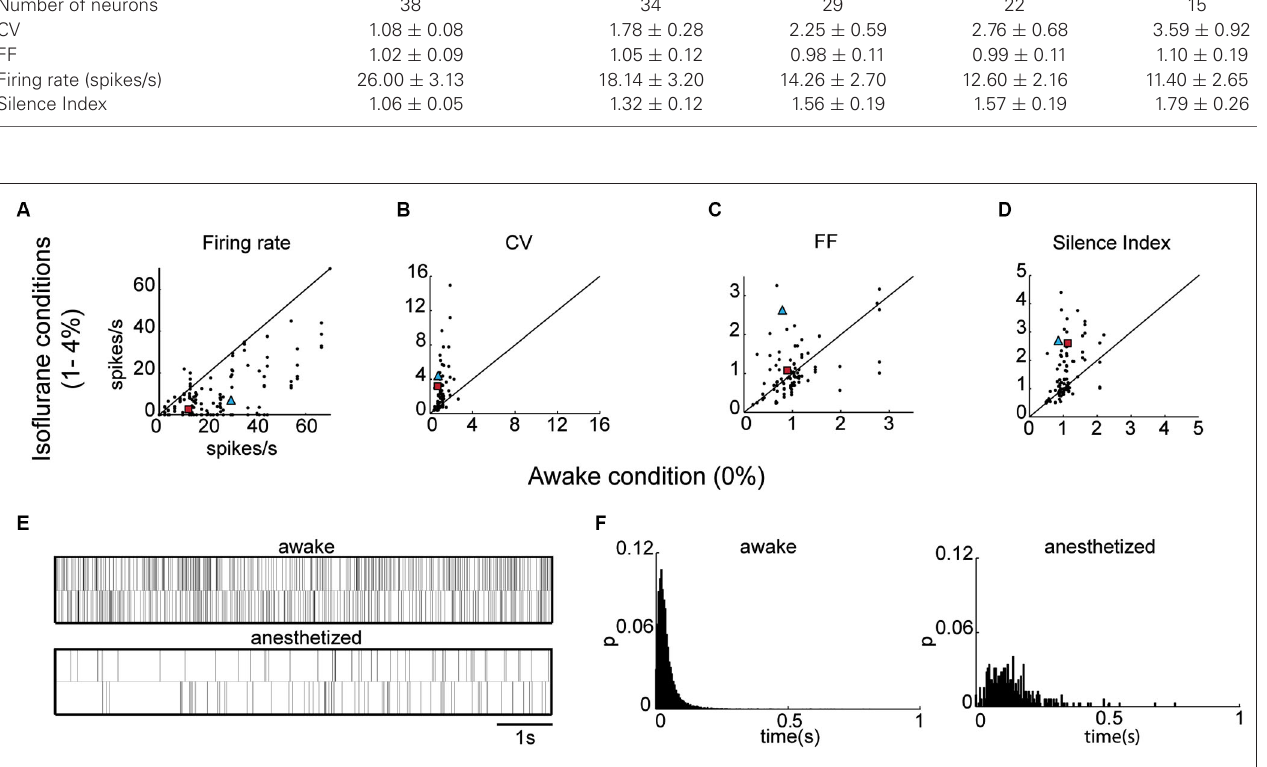
train examples over 20 s of the corresponding neuron marked by a blue triangle in A–D . (F) ISI histograms of the corresponding neuron marked by a red rectangle in A – D